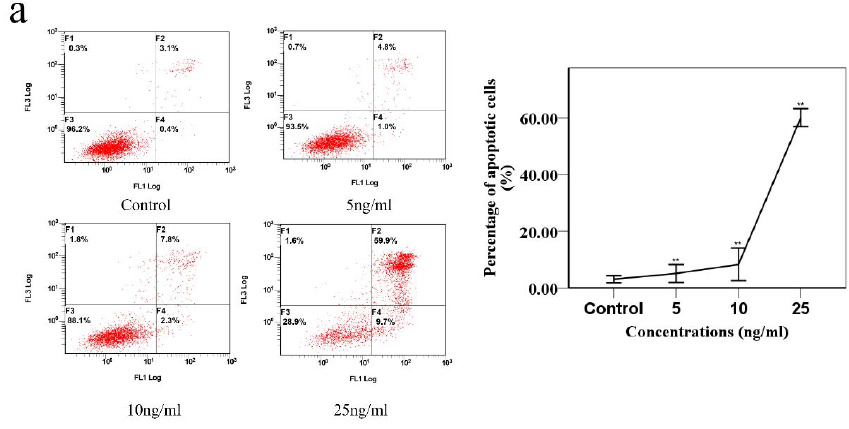
Figure 7. The inhibitory e ff ects of arenobufagin, telocinobufagin, and cinobufotalin on A549 cells Figure 7 . The inhibitory effects of arenobufagin, telocinobufagin, and cinobufotalin on A549 cells ( a ) and H157 cells ( b ) analyzed by 3-(4, 5-dimethylthiazol-2-yl)-2, 5-diphenyltetrazolium bromide ( a ) and H157 cells ( b ) analyzed by 3 ‐ (4, 5 ‐ dimethylthiazol ‐ 2 ‐ yl) ‐ 2, 5 ‐ diphenyltetrazolium bromide (MTT) assay. ** Indicates statistical significance ( p < 0.01). (MTT) assay. ** Indicates statistical significance ( p < 0.01). Table 9. The inhibitory effects of bufadienolides on A549, H157 cells.